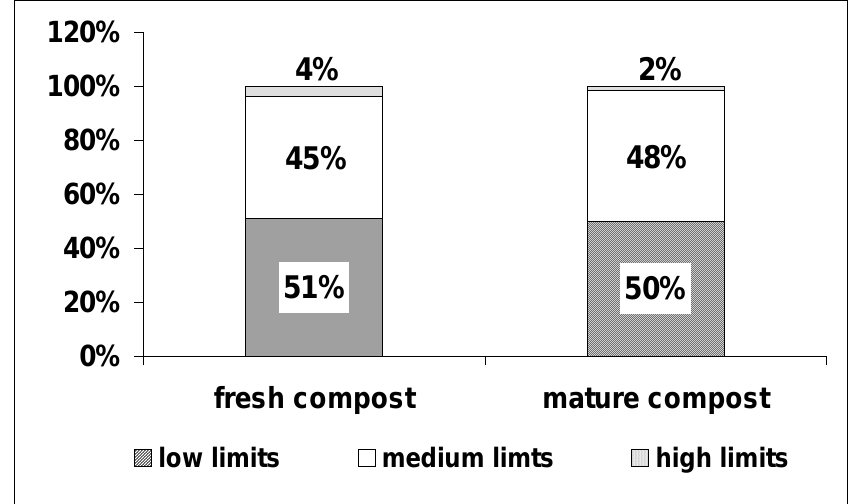
Figure 8: Percentage of fresh (n=779) and mature (n=1955) compost samples from DE, data sets fulfilling the three limit concentration levels ( low, medium, high